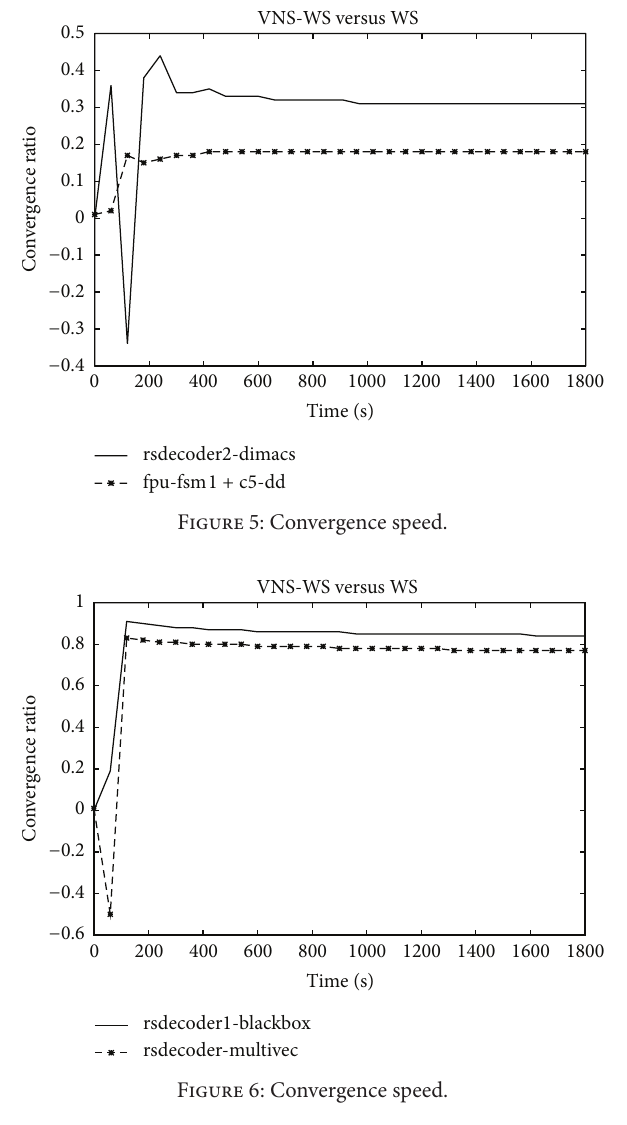
Figure 6: Convergence speed.